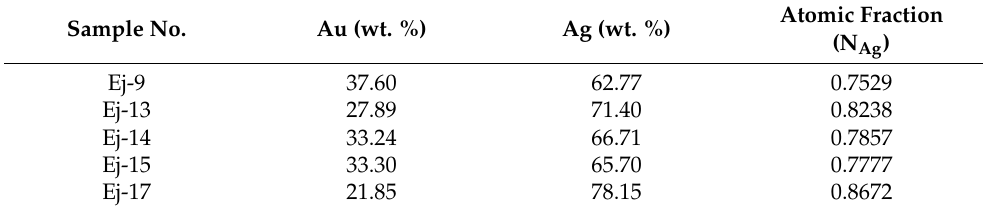
Table 5. EPMA data of electrum from the Eunjeok Au–Ag deposit. Sample